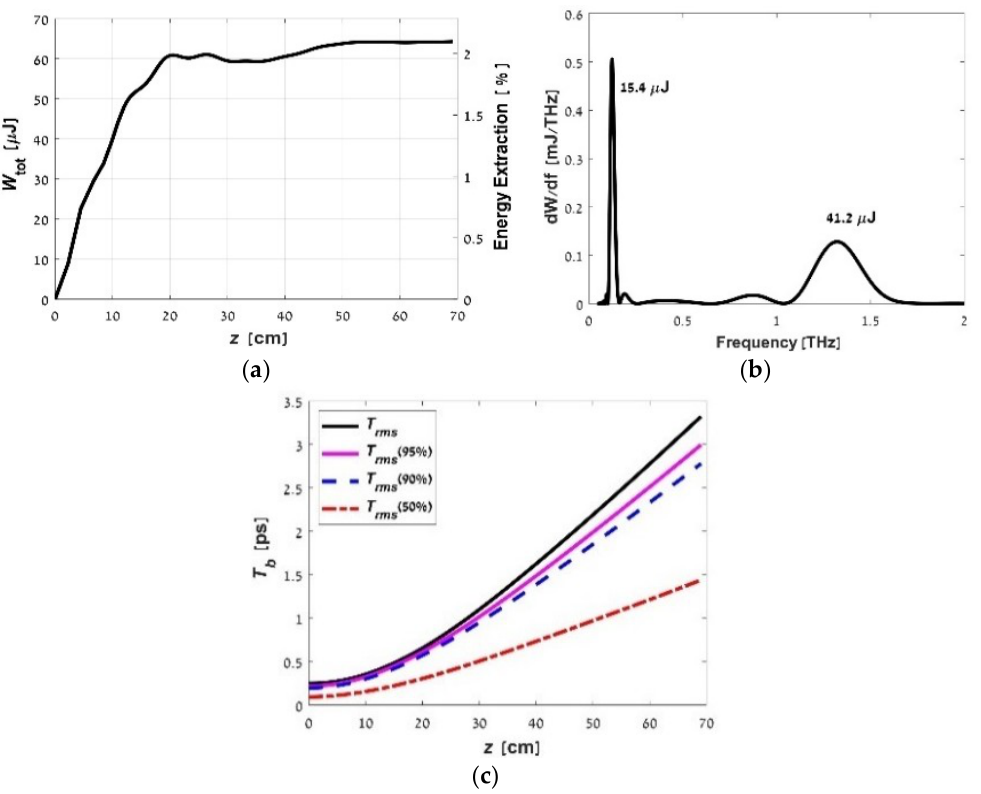
Figure 6. Cyclotron CSR of a bunch with a diameter of 1 mm, an initial duration of 0.25 ps, a charge of 0.5 nC, and a particle energy of 6 MeV in the regime of simultaneous excitation of low- and high-frequency waves: ( a ) radiated energy, ( b ) emission spectrum, and ( c ) change in the rms bunch durations.